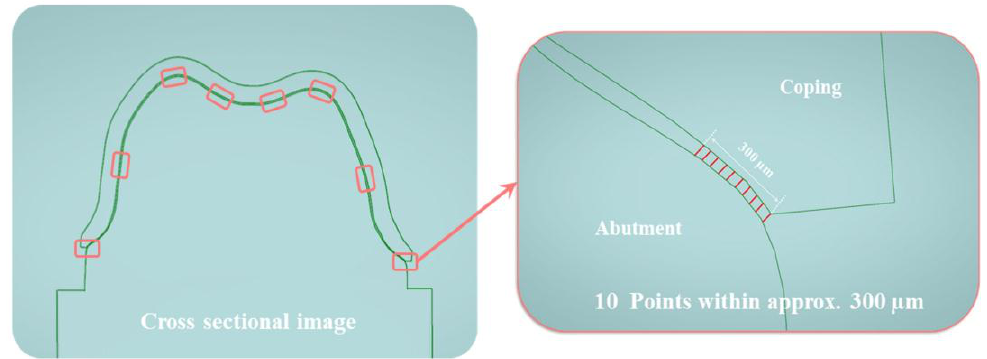
Figure 3. Position of analysis in the cross-sectional image. The right figure indicates the marginal fit and describes that 10 points have been measured within the range of about 300 µm.